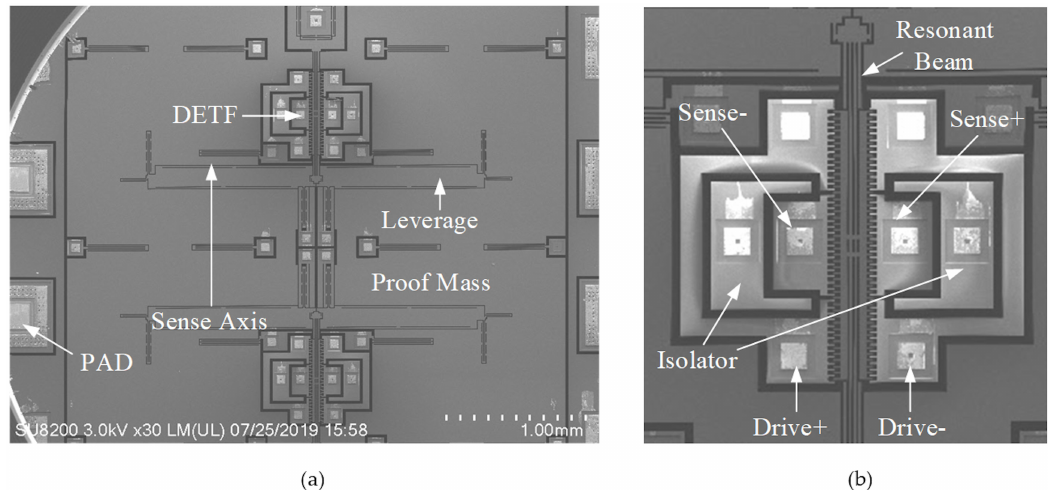
Figure 1. Scanning electron micrographs of the ( a ) MEMS SOA adopted in this work and ( b ) a zoom in view of its